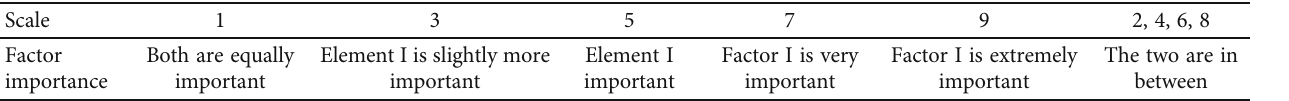
Table 2: 1-9 scale.